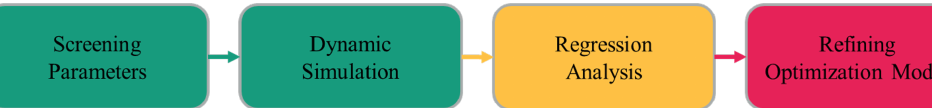
Figure 1. Tool chain to identify most influencing factors concerning the charging, storage, and discharging